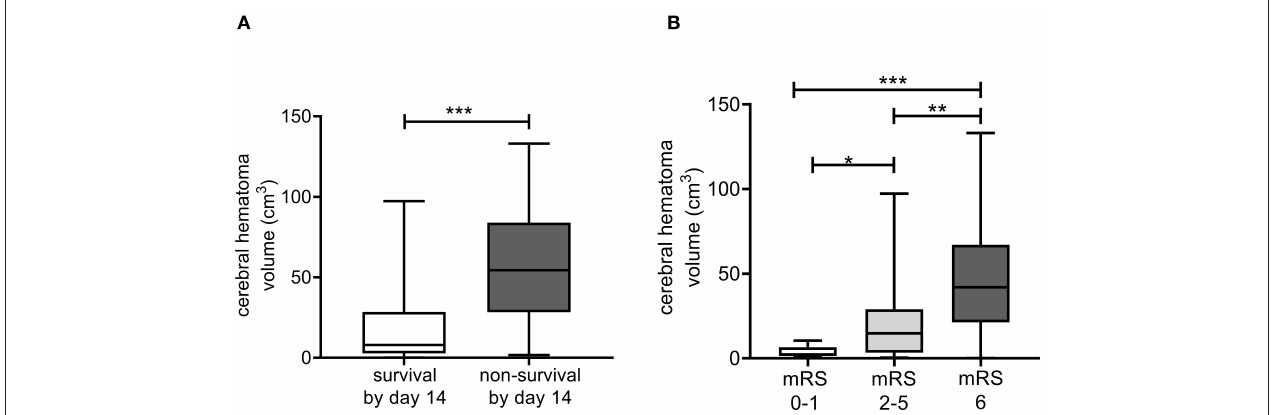
FIGURE 2 | Associations of the estimated cerebral hematoma volume as calculated from on admission CT scans with patient survival by day 14 (A) , and the modified Rankin Scale (mRS) on day 90 (B) . Box and whisker plots indicate median, interquartile range, and total range. mRS, modified Rankin Scale. * p < 0.05, ** p < 0.01, *** p <